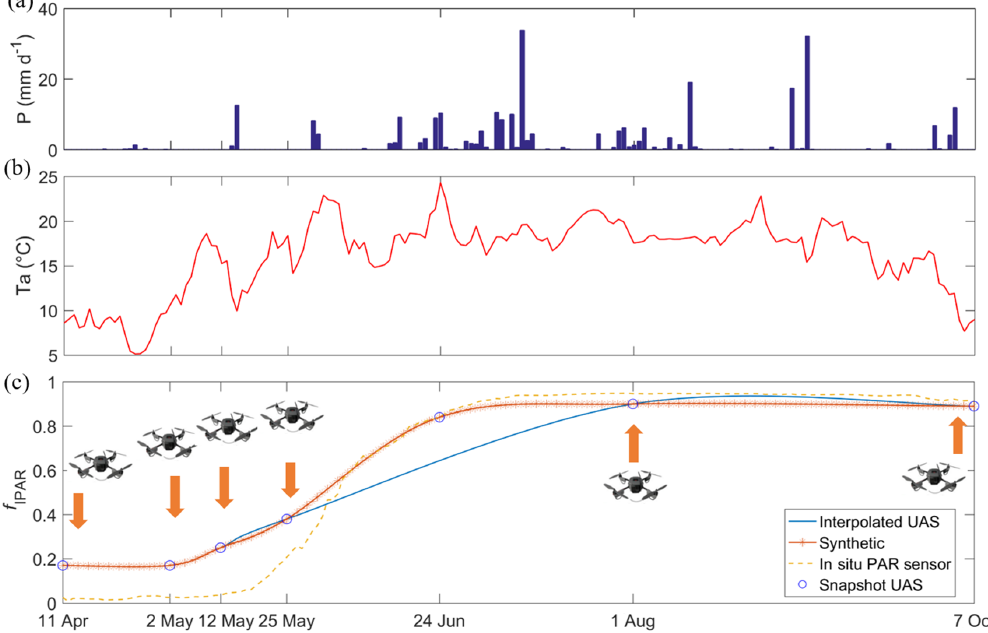
Figure 2. (a) Daily precipitation ( P , mmd − 1 ), (b) daily air temperature ( T a , ◦ ), and (c) daily fraction of the intercepted PAR ( f IPAR ) interpolated from UAS-based NDVI during the 2016 growing